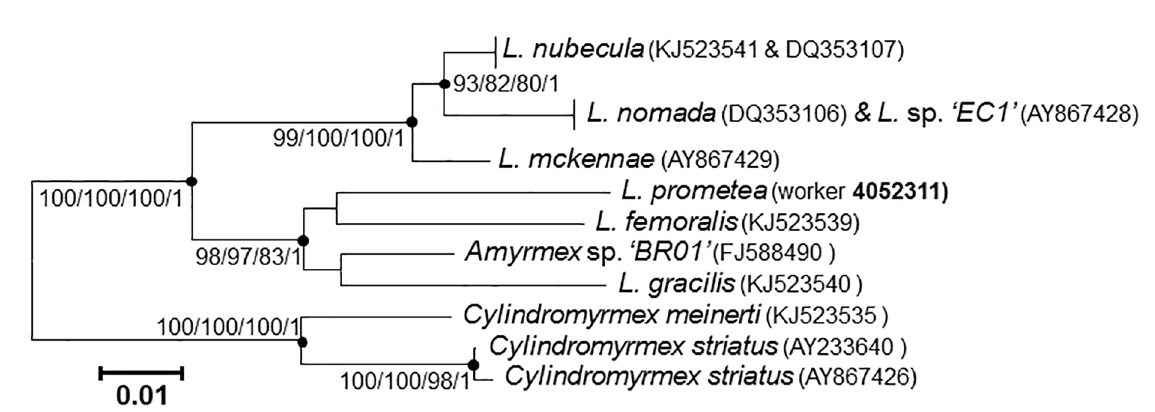
Fig. 12. Neighbour-joining tree showing p-distances among DNA sequences of the wingless nuclear marker obtained for specimens of Leptanilloides Mann, 1823, Amyrmex Kusnezov, 1953 and Cylindro- myrmex Mayr, 1870 (as outgroup), available in GenBank and sequenced here (specimen code 4052311). Labels provide species identifications and field IDs (in bold) or GenBank or BOLD numbers. Values at nodes correspond to the bootstrap values (%) and posterior probabilities obtained in the Neighbour- joining/parsimony/maximum likelihood/Bayesian inference analyses. Bootstrap values < 80% and posterior probabilities < 0.95 are not